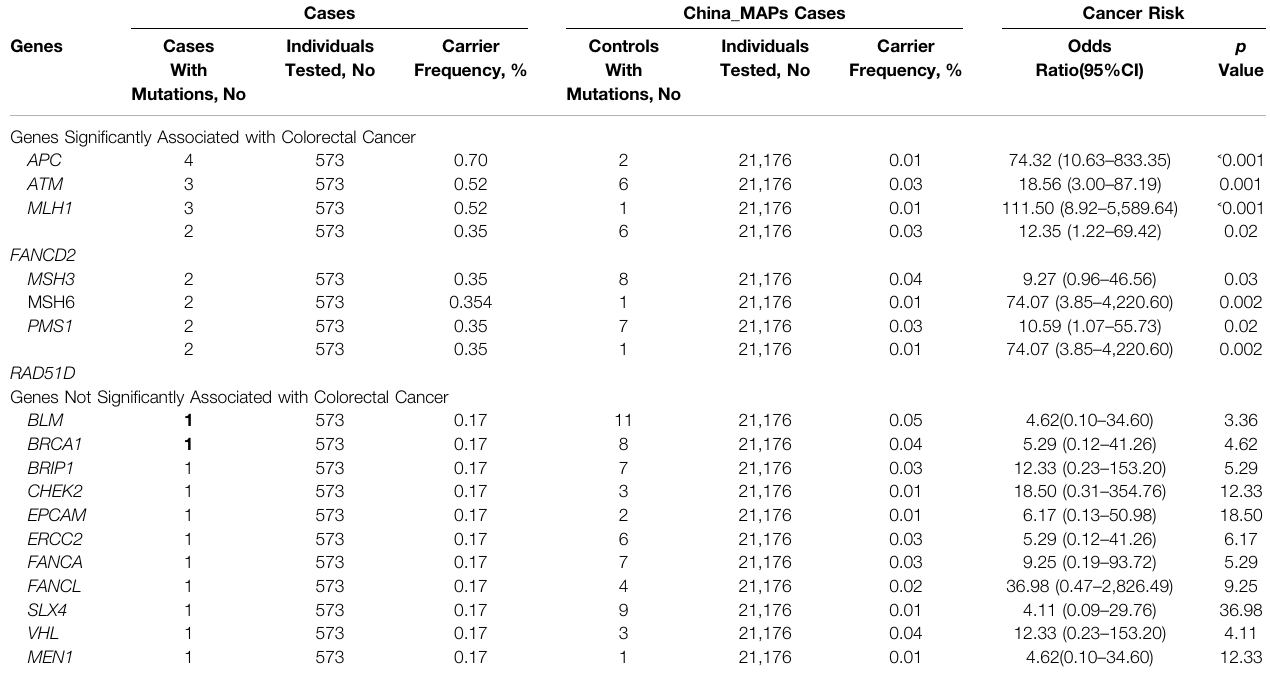
TABLE 3 | Comparison of mutation carriers by panel gene between colorectal cancer cases and China_MAPs control cases.